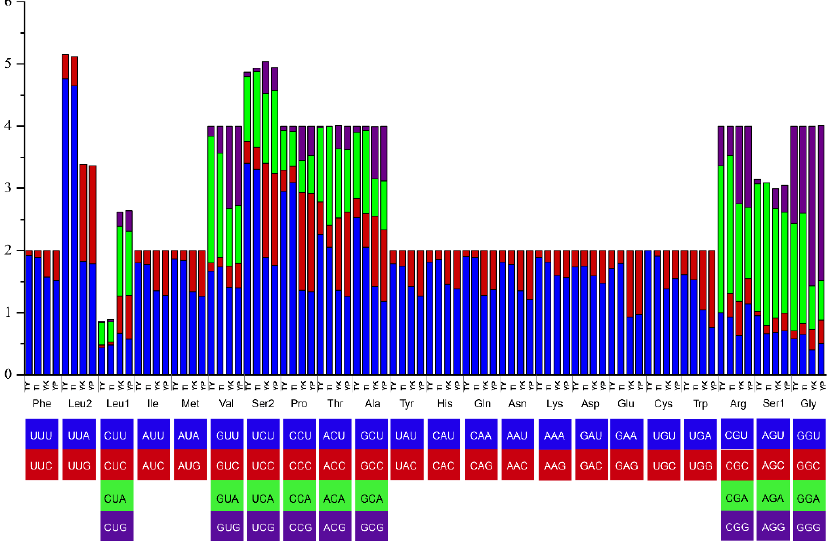
Figure 3. Relative synonymous codon usage of PCGs in the Trogloneta and Yamaneta mitogenomes. TY, Trogloneta yunnanense ; TI, Trogloneta yuensis ; YK, Yamaneta kehen ; YP, Yamaneta paquini .